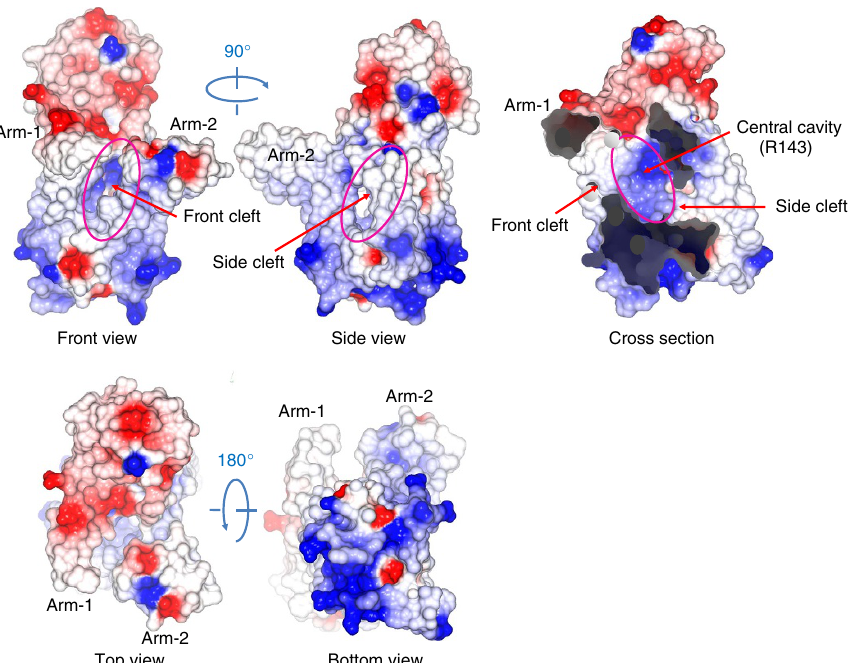
Figure 4 | Surface presentation of electrostatic potential. Positively charged regions of the molecular surface of Lgt are shown in blue, and negatively charged regions in red. The distribution of charges satisfies the positive-inside rule of transmembrane protein topology. Structure presentations were generated using the program Coot